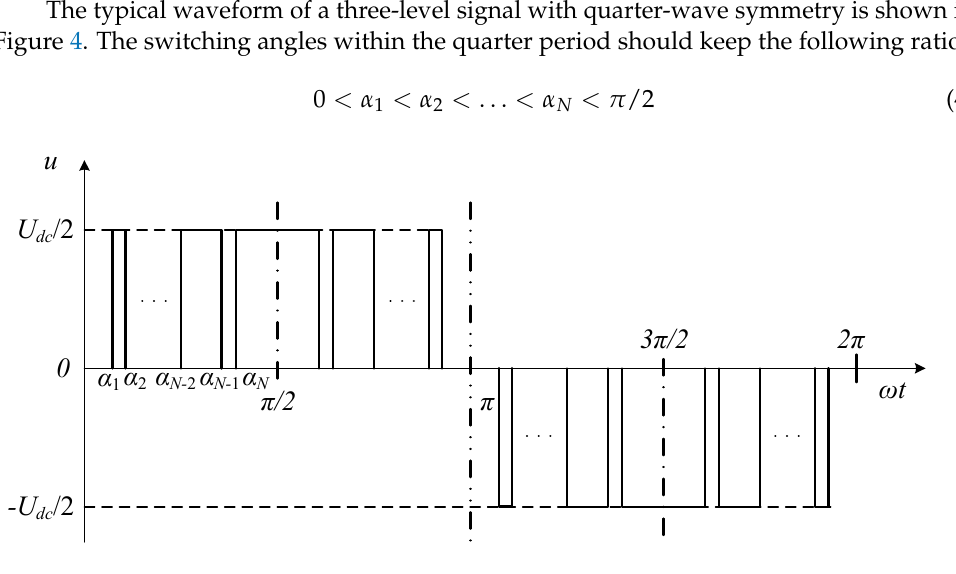
Figure 4. Waveform of a three-level signal with quarter-wave